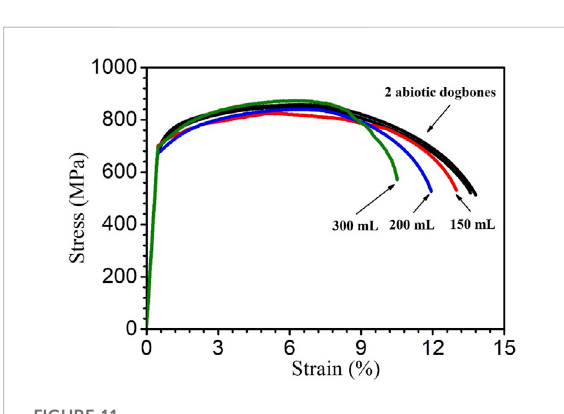
FIGURE 11 Stress – strain curves for 2 replicate abiotic X80 dogbone coupons and dogbone coupons (with corrosion products removed) obtained after 14-day incubation with